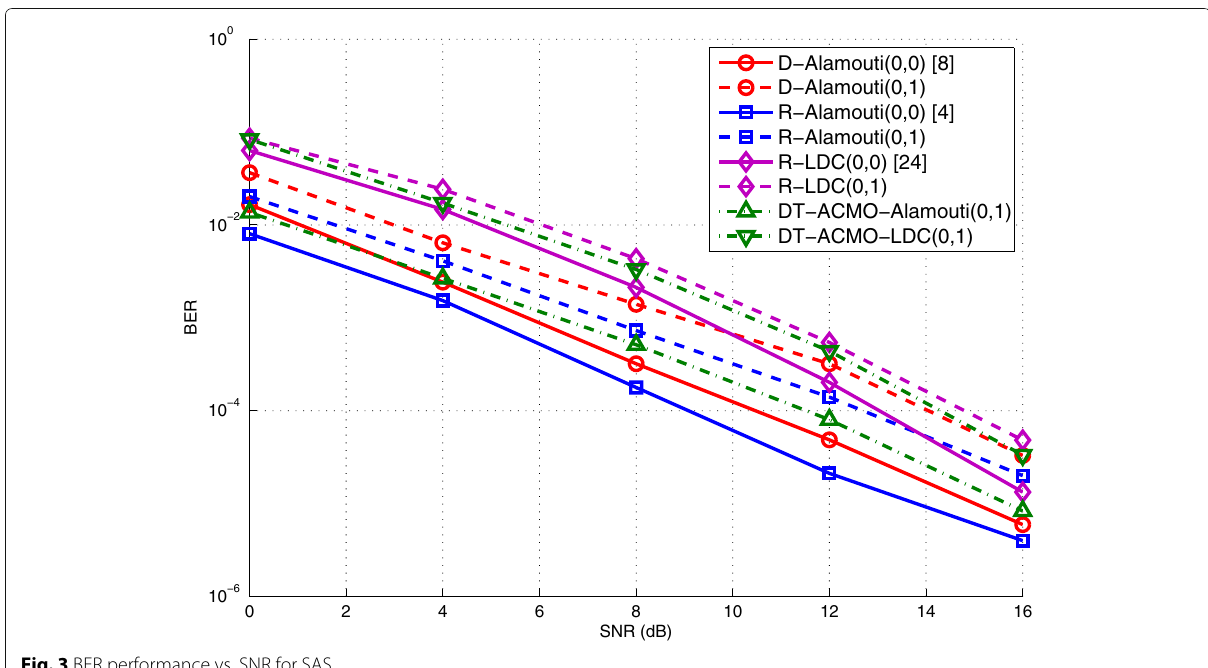
Fig. 3 BER performance vs. SNR for SAS